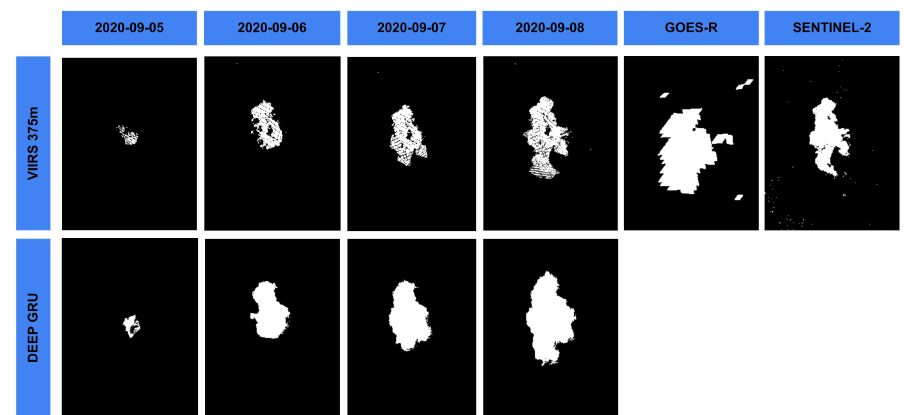
Figure 12. Burned area progression mapping of VIIRS 375 m active fire product and proposed method for 5 September 2020 to 8 September 2020 until Sentinel-2 image is available. Accumulated image from GOES-R active fire product from 5 September 2020 to 8 September 2020 is served as the baseline.